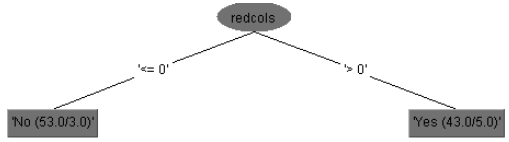
Figure 4. The decision tree without feature subsets (using 29 attributes).